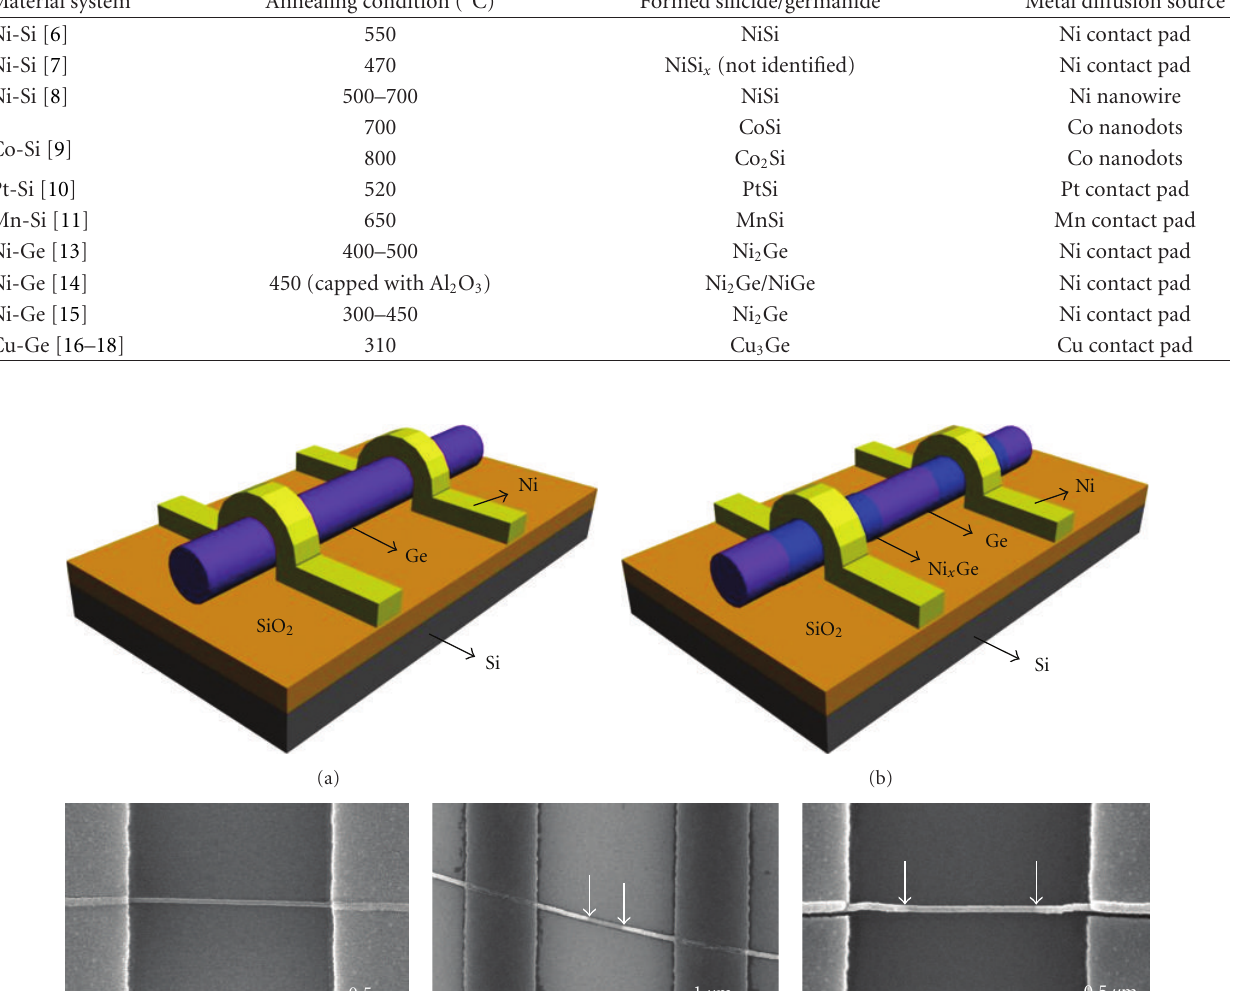
beam without interference with images of the